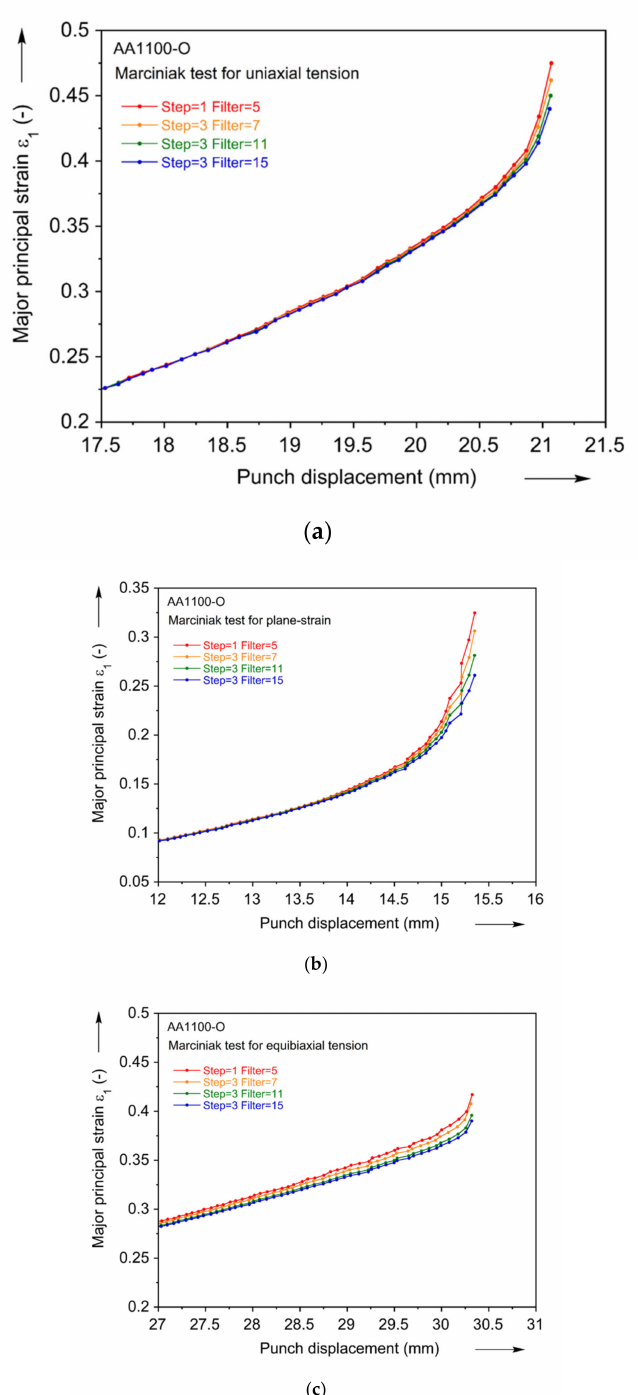
Figure A3. DIC parameter optimization for major principal strains for ( a ) uniaxial tension, ( b ) plane-strain, and ( c ) equibiaxial tension of Marciniak